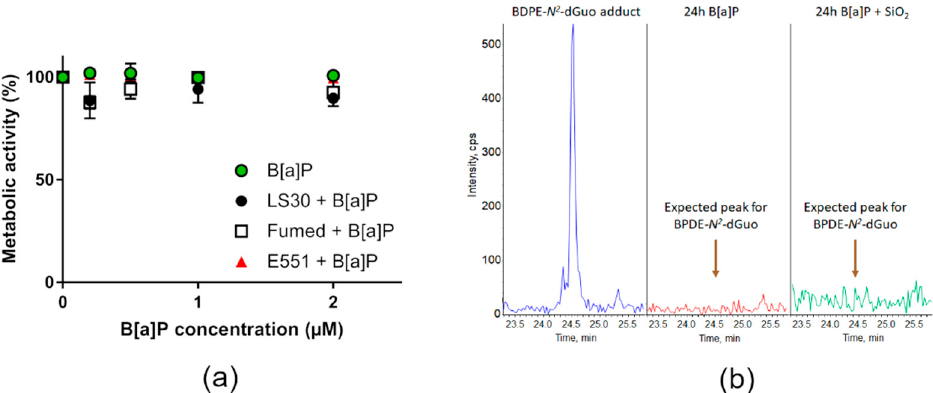
Figure 6. Cyto- and genotoxicity of B[a]P or SiO 2 co-exposed with B[a]P towards RAW264.7 cells. ( a ) Cell metabolic activity, assessed via the WST1 assay; ( b ) HPLC-MS/MS chromatograms obtained upon quantification of BPDE adduct to DNA showing the expected position of the BPDE adduct peak (BPDE- N 2 -dGuo) (blue, left), of DNA extracted from cells exposed to 2 µM B[a]P (red, middle) and of DNA extracted from cells exposed to 2 µM B[a]P and 10 µg/mL Fumed SiO 2 (green, right).